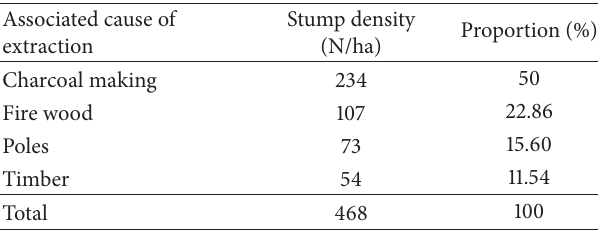
Table 9: Activities and stump density indicating extraction level in miombo woodlands.